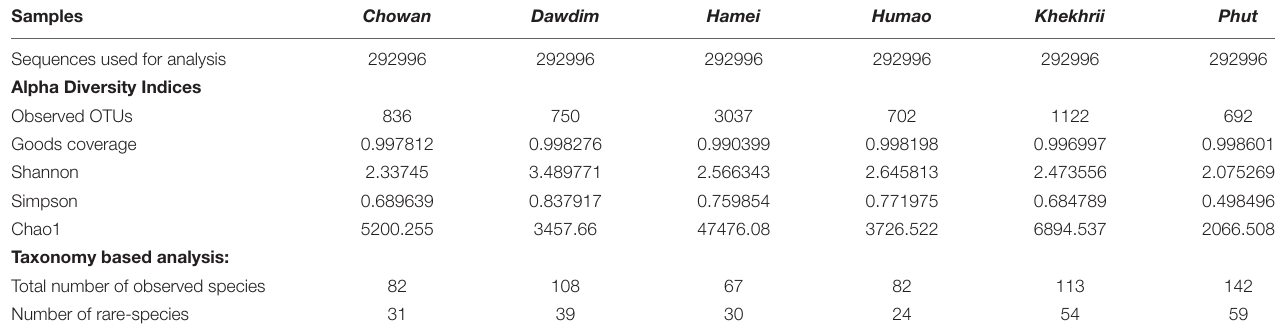
TABLE 1 | Sequence statistics, alpha diversity matrix and species level taxonomy number observed for starter culture samples.